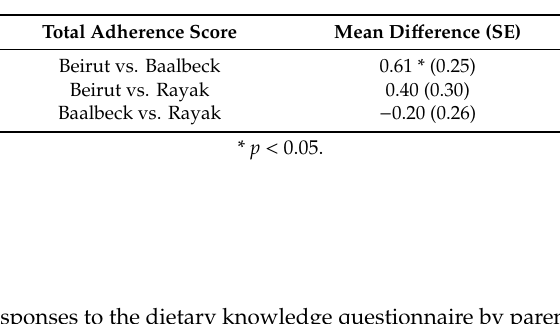
Table A8. Total adherence score di ff erences between the three locations (Beirut, Baalbeck and Rayak).